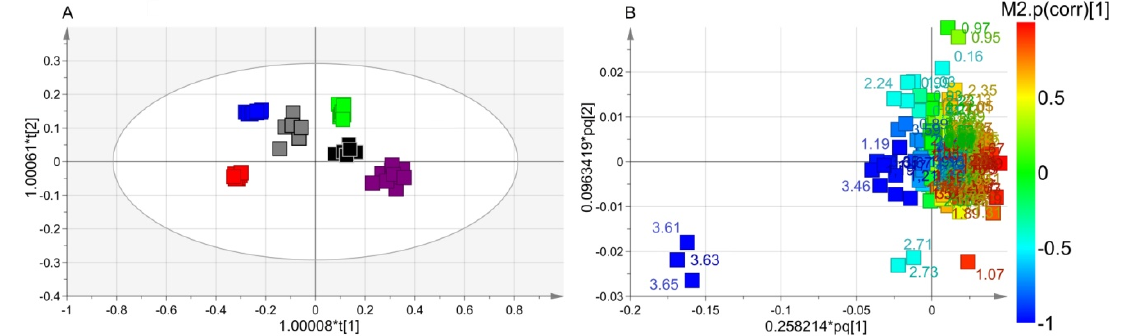
Figure 3. Orthogonal Projection to Latent Structure Discriminant Analysis (OPLS-DA) of Xcc biofilm treatment. ( A ) Scores plot showing the separation between Xcc (green squares), hydroxyapatite (HA) (black squares), Xcc ϕ 1 + C20:0 (gray squares), C20:0 (purple squares), Xcc ϕ 1 (blue squares) and Xcc ϕ 1 + HA + C20:0 (red squares). ( B ) Loadings plot reporting the nuclear magnetic resonance (NMR) variables corresponding to metabolites responsible for class separation, displaying | p (corr) |> 0.7.